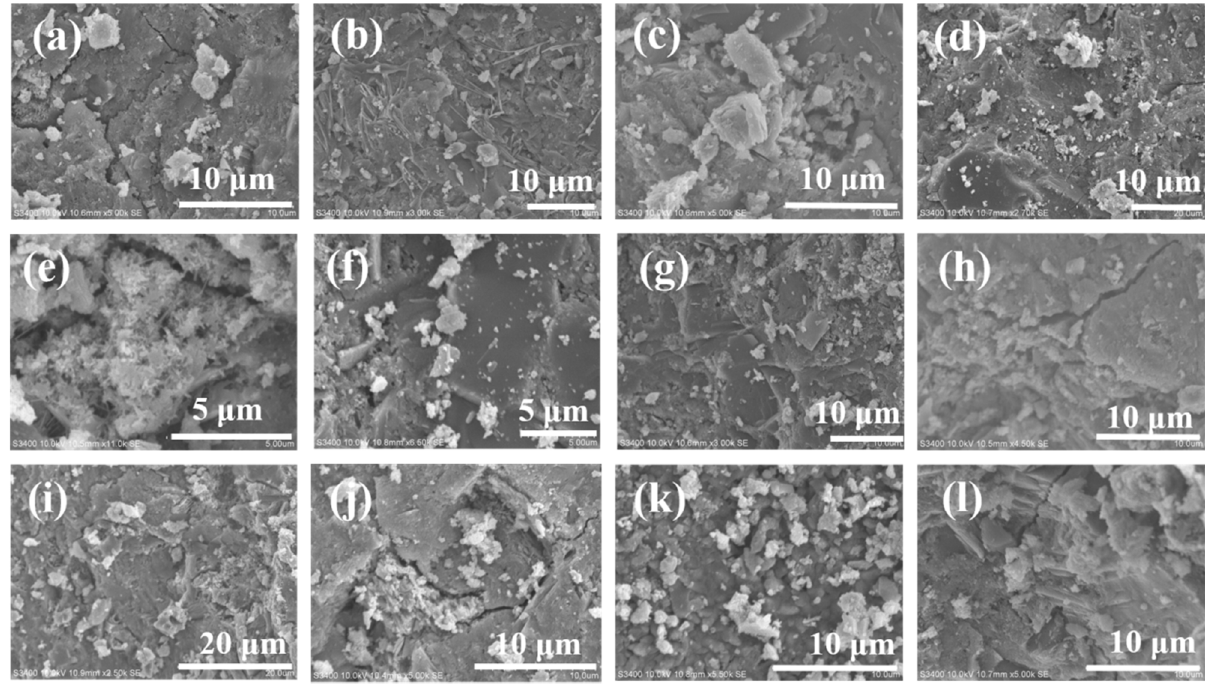
Figure 8: The SEM images of inorganic binders: ( a ) KL binder; ( b ) MK - 1 binder; ( c ) MK - 2 binder; ( d ) BFS - 1 binder; ( e ) BFS - 2 binder; ( f ) FA - 1 binder; ( g ) FA - 2 binder; ( h ) SF binder; ( i ) BEN binder; ( j ) SB binder; ( k ) MP binder; and ( l ) QP binder.